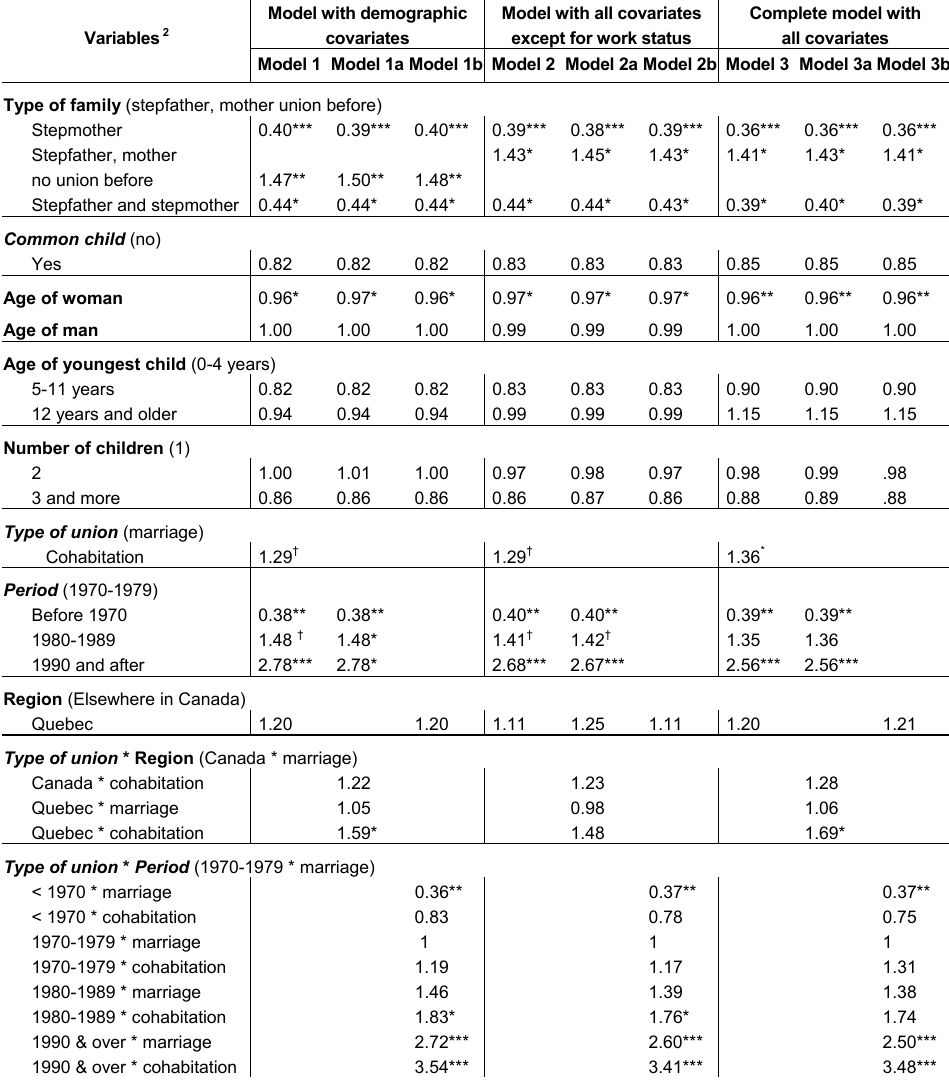
Complete model with all covariatesVariables